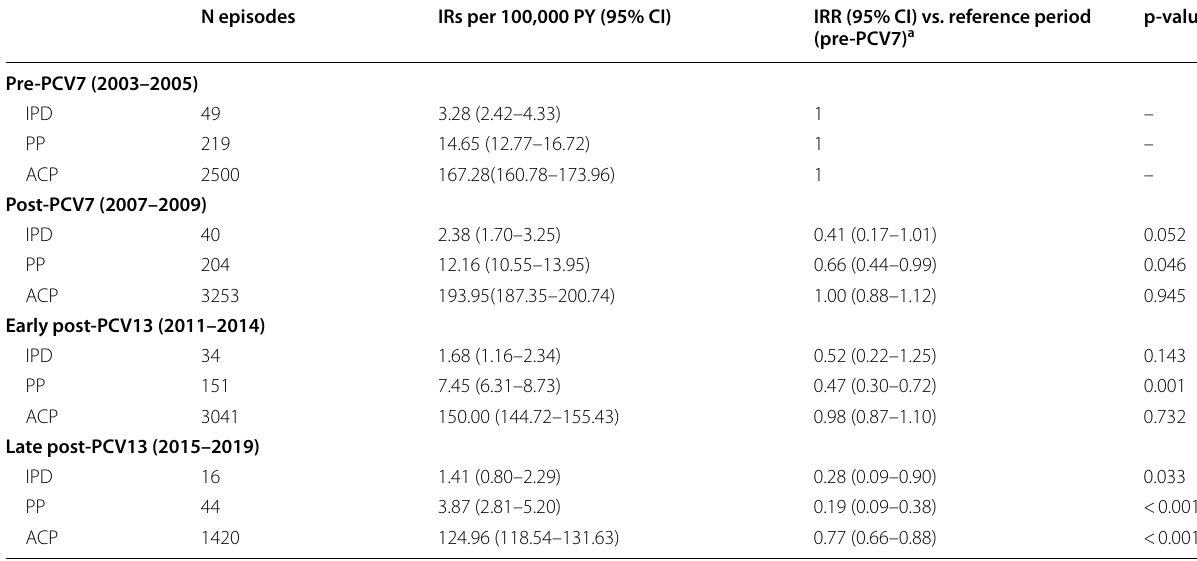
Table 3 IRs and IRRs before and after the introduction of PCV7 and